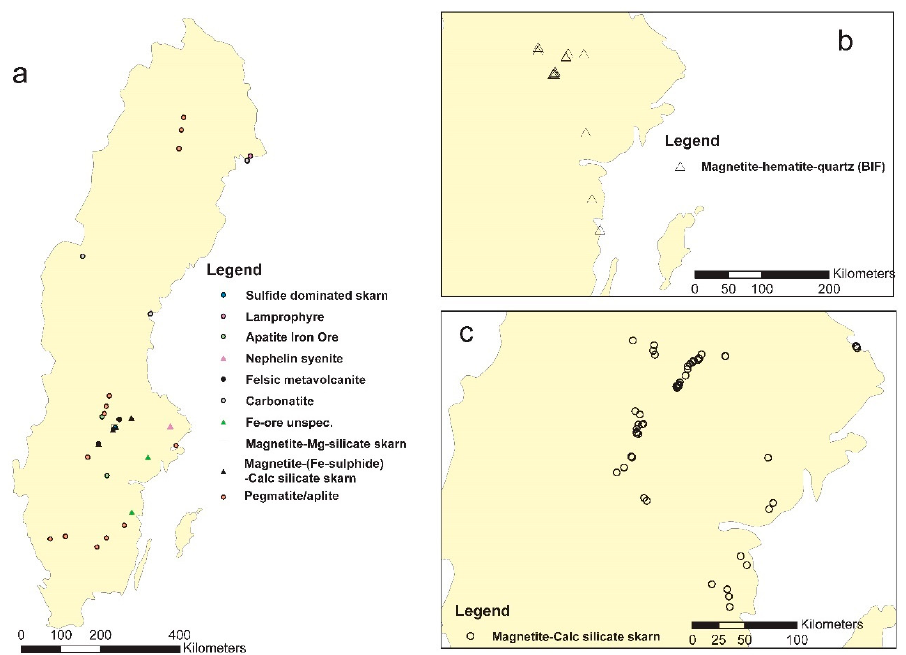
Figure 4. Simplified location map of samples in the EURARE project: ( a ) an overview of sample locations and types, excluding magnetite-calc silicate skarn and BIF ones; ( b ) magnetite-hematite-quartz samples; ( c ) magnetite-calc silicate skarn samples.